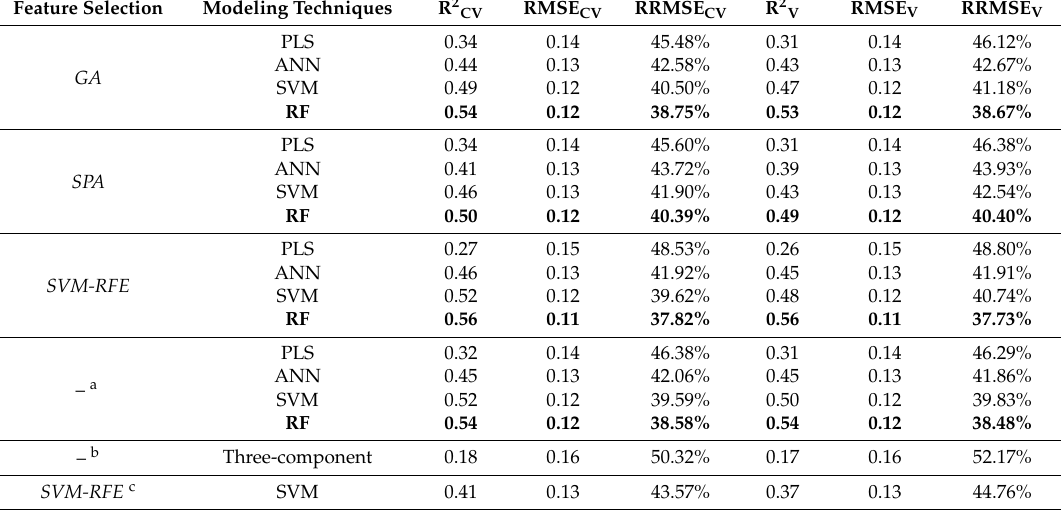
Table 4. Model performances of cross validation (CV) and independent validation (V) for nanoplankton size fractions obtained by different combinations of feature selection and modelling techniques. Feature selection techniques included genetic algorithm (GA), successive projection algorithm (SPA), and recursive feature elimination based on support vector machine regression (SVM-RFE). The modeling techniques included partial least square (PLS) regression, artificial neural network (ANN), support vector machine (SVM), and random forests